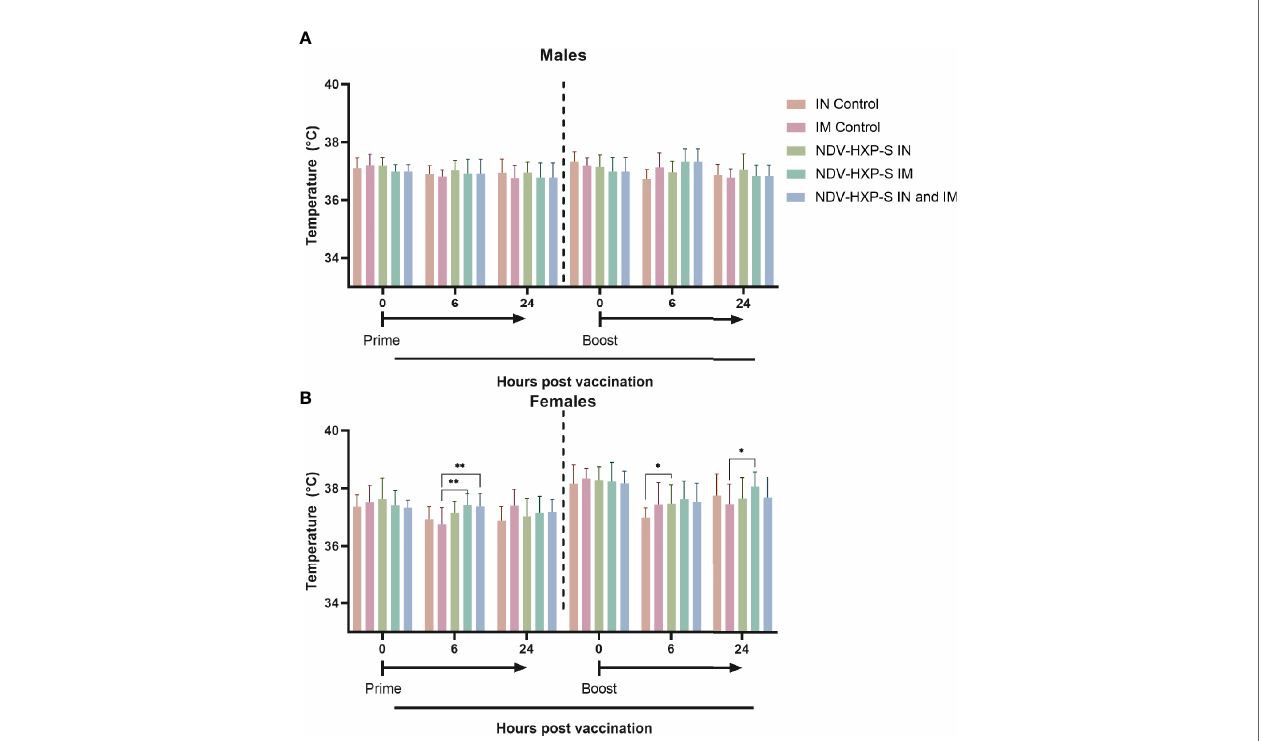
FIGURE 2 | Kinetics of body temperature in vaccinated rats. Individual body temperatures (°C) were taken at 0, 6 and 24 hours post vaccination, after both prime (left side) and boost (right side) vaccine doses, in both males (A) and females (B) . Geometric mean of daily body temperature with geometric standard deviation (SD) for the IN control, IM control, IN vaccinated, IM vaccinated, and IN-IM vaccinated groups is shown. Statistically signi fi cant differences between the vaccinated groups and their respective controls are shown. The IN-IM administered group was compared with the IM control group. Statistical signi fi cance is indicated as follows: *P < 0.0413; **P <